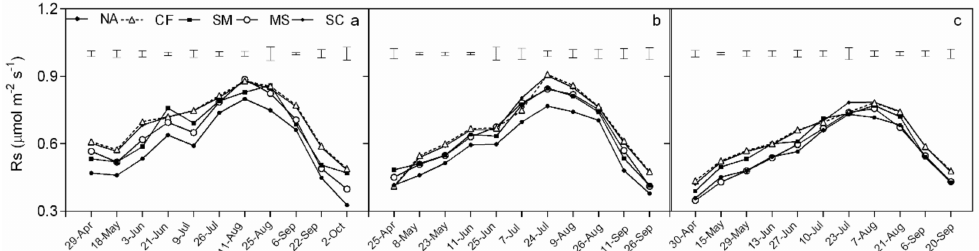
Figure 7. Soil respiration (Rs) during the 2014 ( a ), 2015 ( b ), and 2016 ( c ) growing seasons by